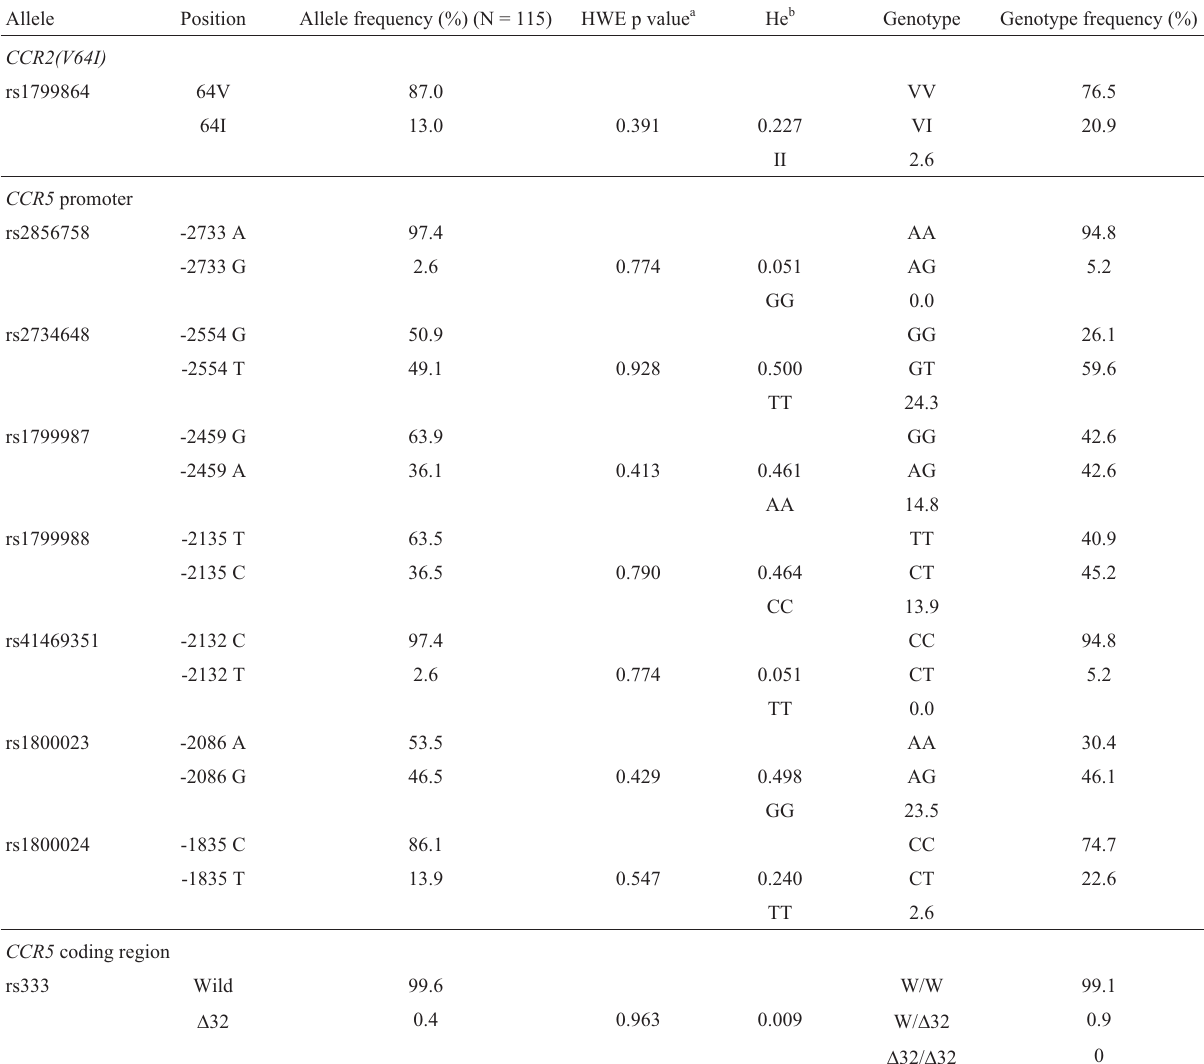
Table 2 - Allele frequency (%), Hardy-Weinberg equilibrium (HWE), expected heterozygosity (He) and genotype distribution of all the tested loci in the sample population.